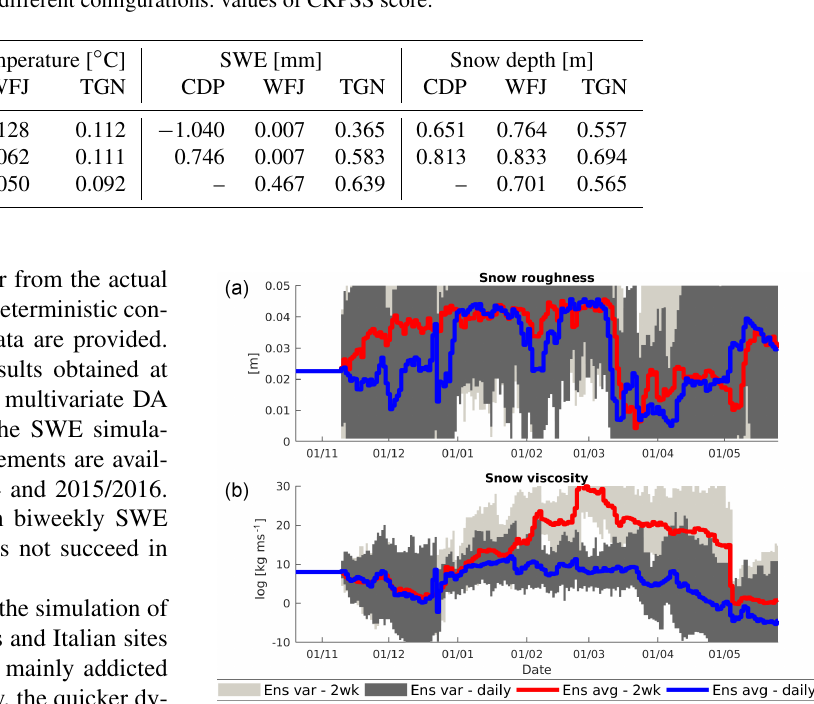
Table 6. Comparison of DA performance under different configurations: values of CRPSS score.